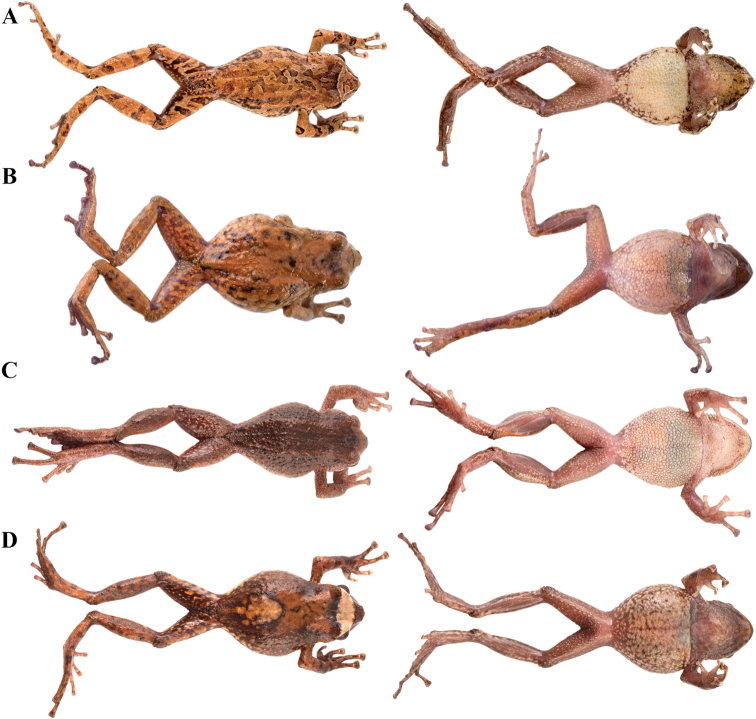
Color variation in live individuals of Pristimantis
verrucolatus sp. nov. AQCAZ 46982 (holotype, male, SVL 28.4 mm) BQCAZ 45195 (male, SVL 34.5) CQCAZ 46993 (female, SVL 46.8 mm) DQCAZ 46999 (male, SVL 28.4 mm). Dorsal view on the left, ventral view on the right.